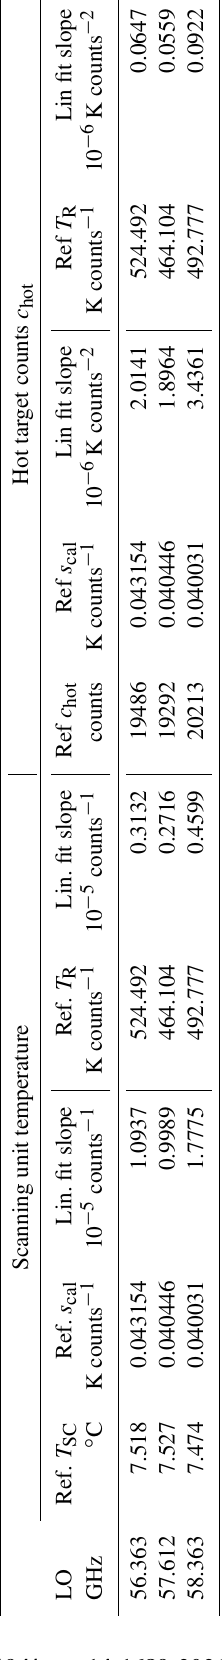
Table 4. Linear fit values linking the noise diode offset temperature to MTP noise diode offset counts.